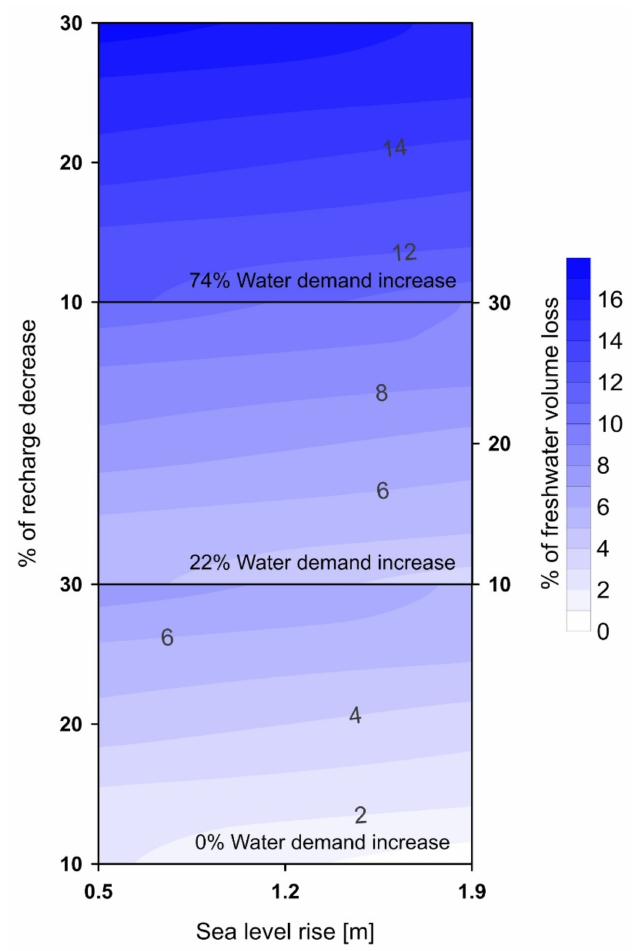
Figure 7. Plot of freshwater volume loss (%) estimated for the 2100 scenario by comparing aquifer conditions obtained without any climate change effect (future projection of present day forcings) with aquifer conditions determined by the combination of the modeled climate change consequences (sea-level, recharge and water